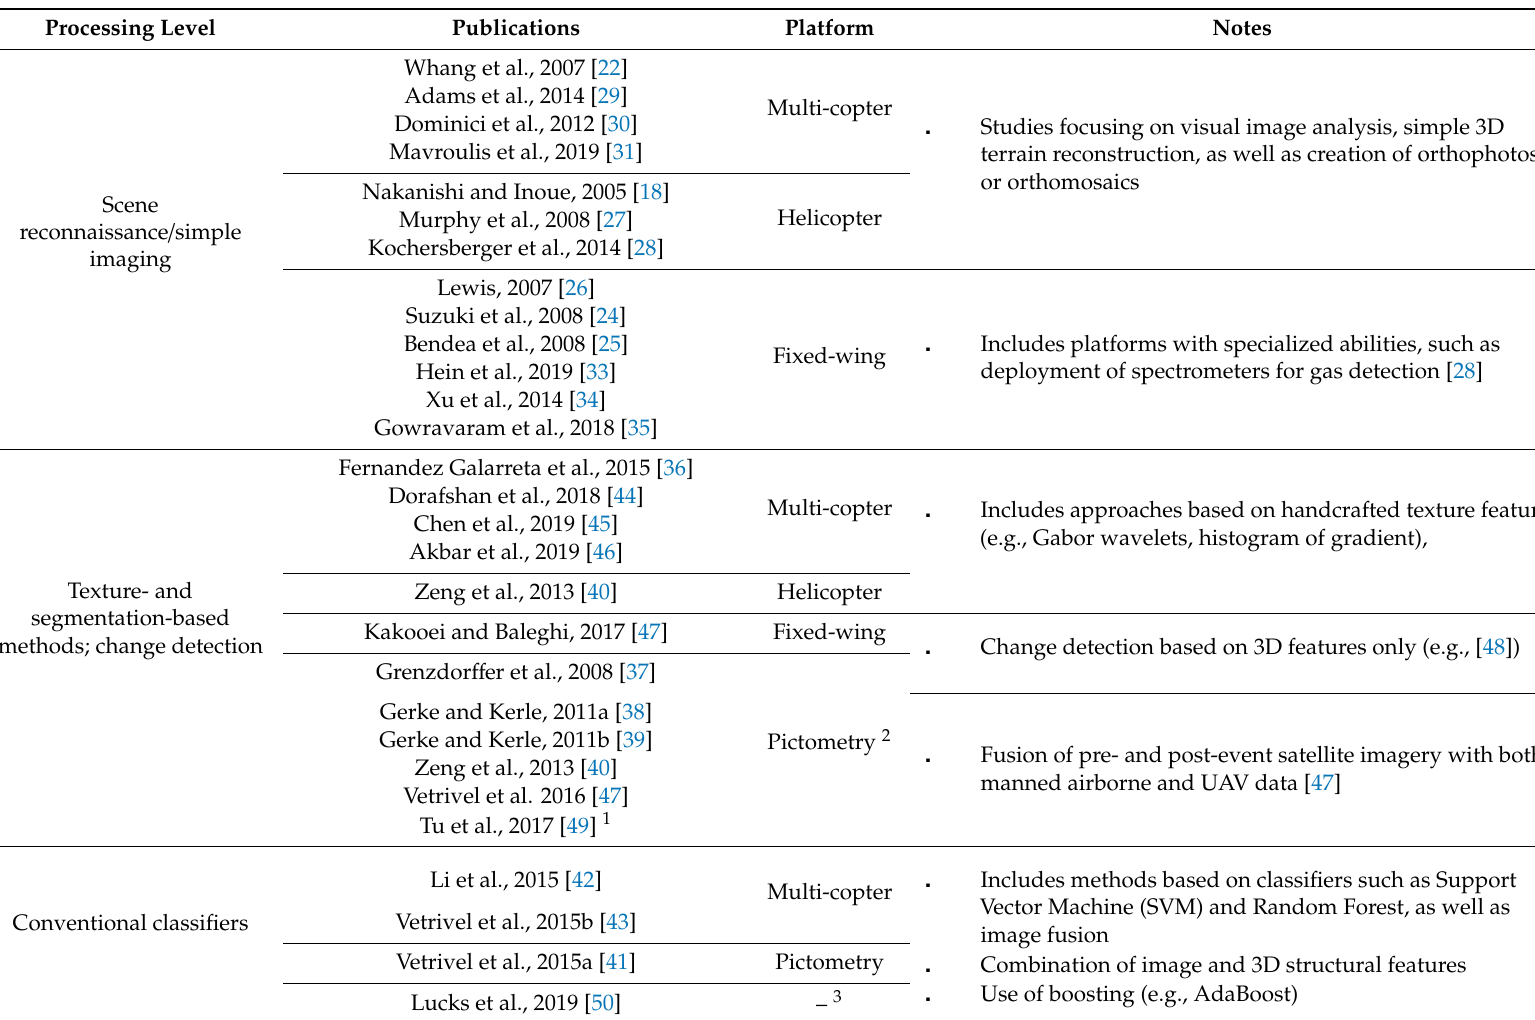
Table 1. Summary the relevant technical papers reviewed in Section 2, organized by level of technical